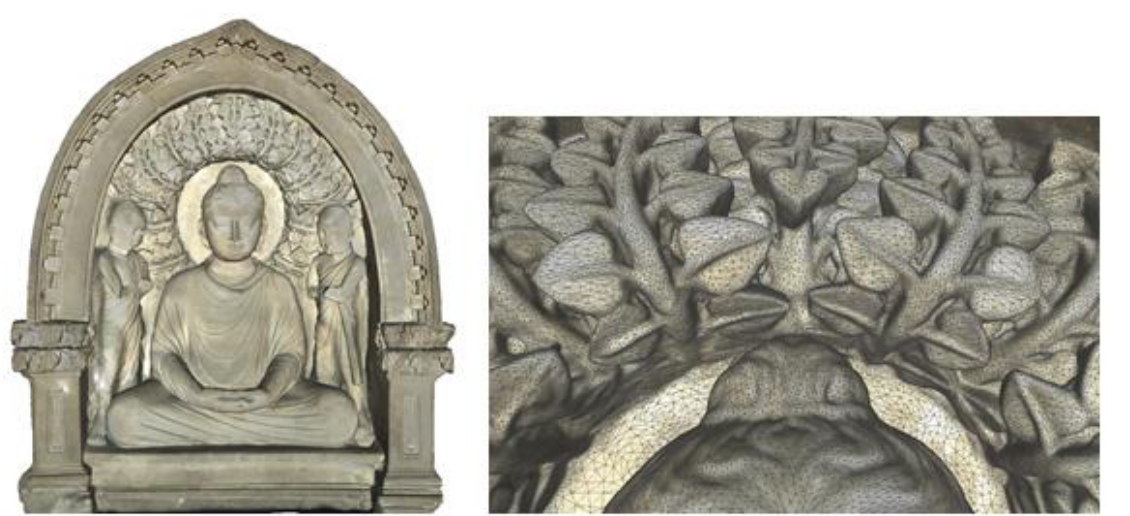
Figure 12. 3D base model of the “Buddha” statue: overview (on the left ) and mesh visible (on the right ).